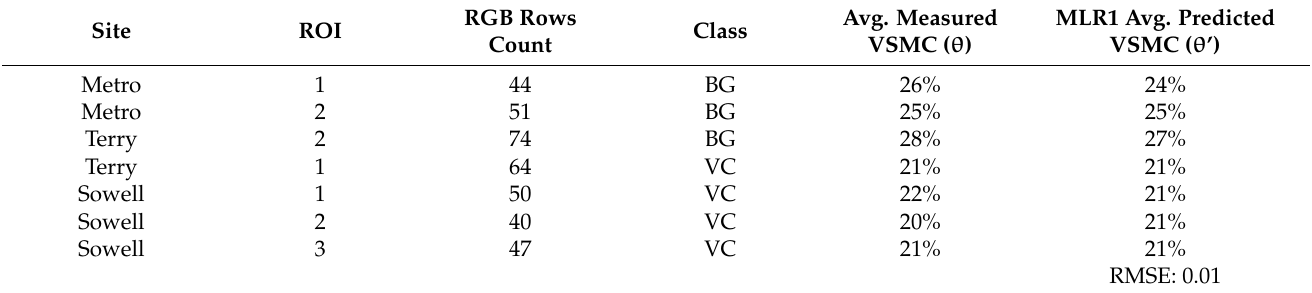
Table 8. MLR model data characteristics *.